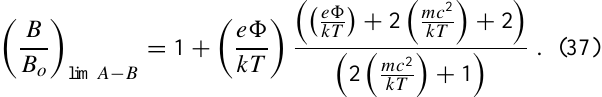
limiting lines and distribution function contours shown in Fig. 1a. For the upper curves in Fig. 2 with and 200, however, the transitions occur at increasingly